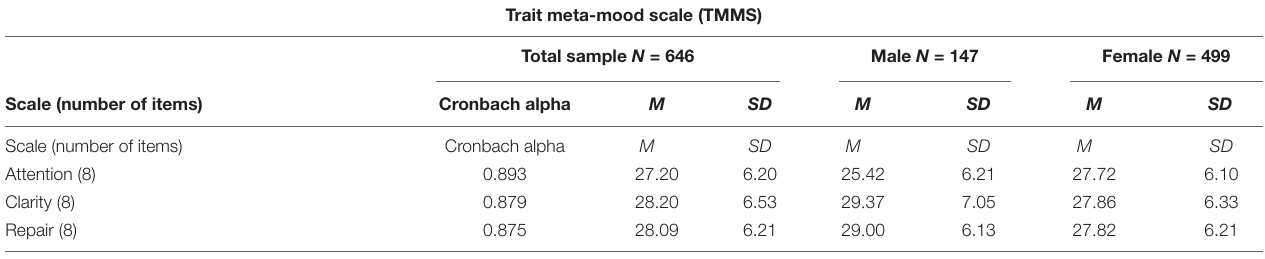
TABLE 4 | Cronbach’s alphas, means, standard deviations of the variables examined.